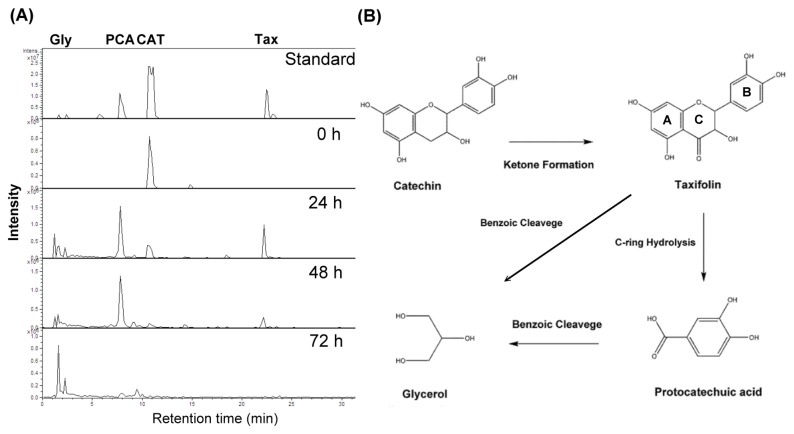
Metabolic pathway for (-)-catechin transformed by Pseudomonas sp. CRF3-Ps-1 was analysed by the LC-ESI-MS/MS method (A).(-)-Catechin (CAT) was transformed into taxifolin (Tax) via ketone formation during the first 24 h. Subsequently, C-ring hydrolysis occurred and generated protocatechuic acid (PCA) and glycerol (Gly). Finally, (-)-catechin was transformed into glycerol 72 h after incubation. The possible transformation hypothesis is also illustrated (B).